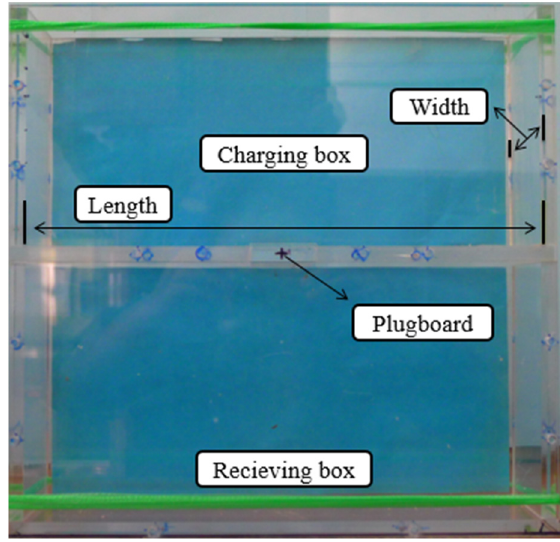
Processes 2021 , 9 , x FOR PEER REVIEW